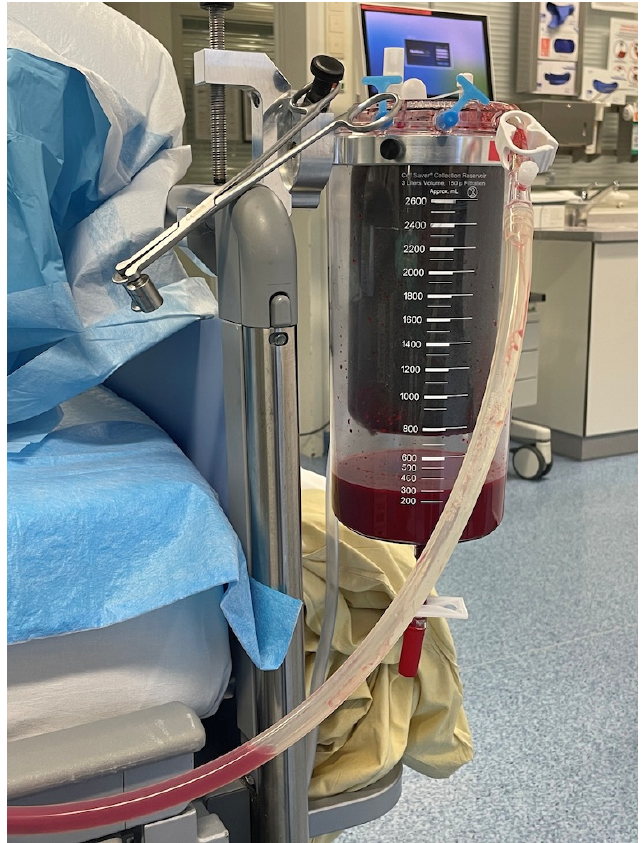
Figure 1. Cell saver reservoir at the bedside of an intensive care patient.